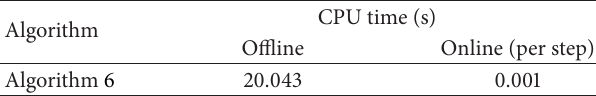
Table 2: The numerical burdens in Example